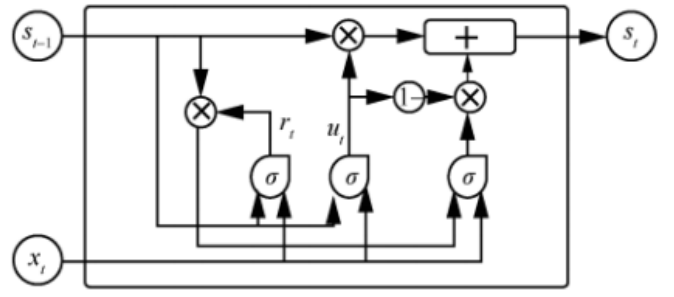
Figure 1. Gated Recurrent hidden layer